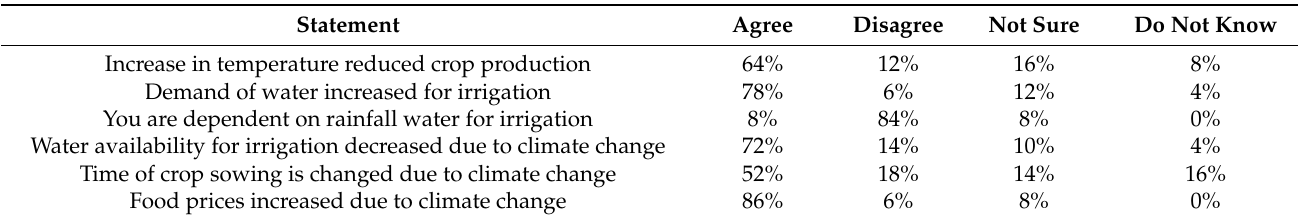
Table 4. Perceptions of farmers about risk due to climate change.